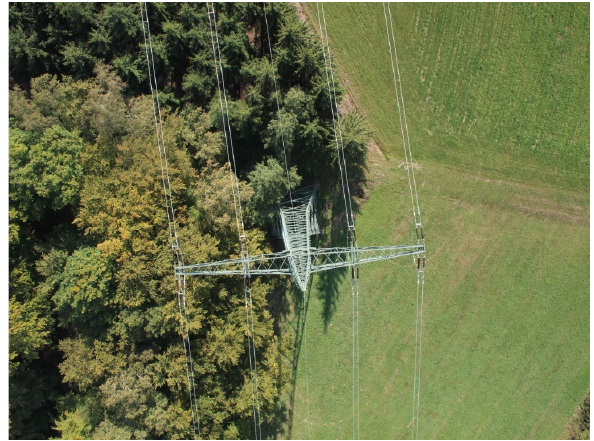
Figure 4. Typical flight